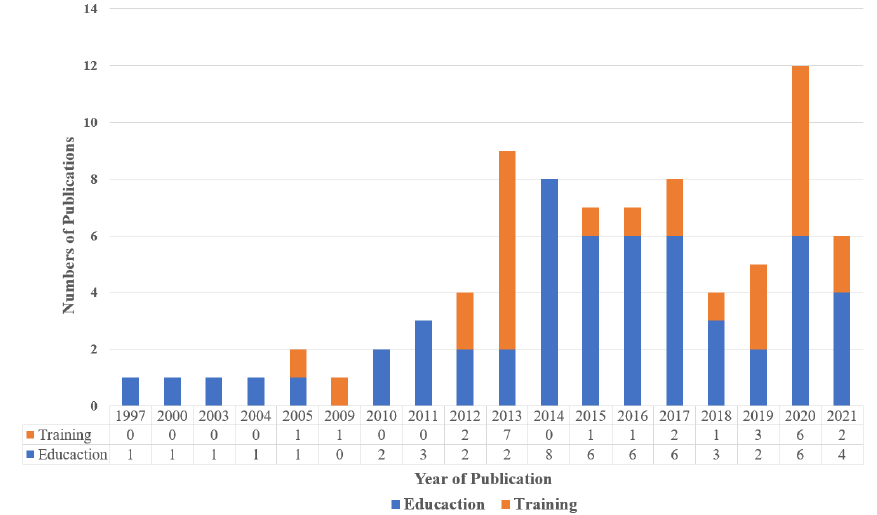
Figure 5. Number of publications from 1997 to 2021.